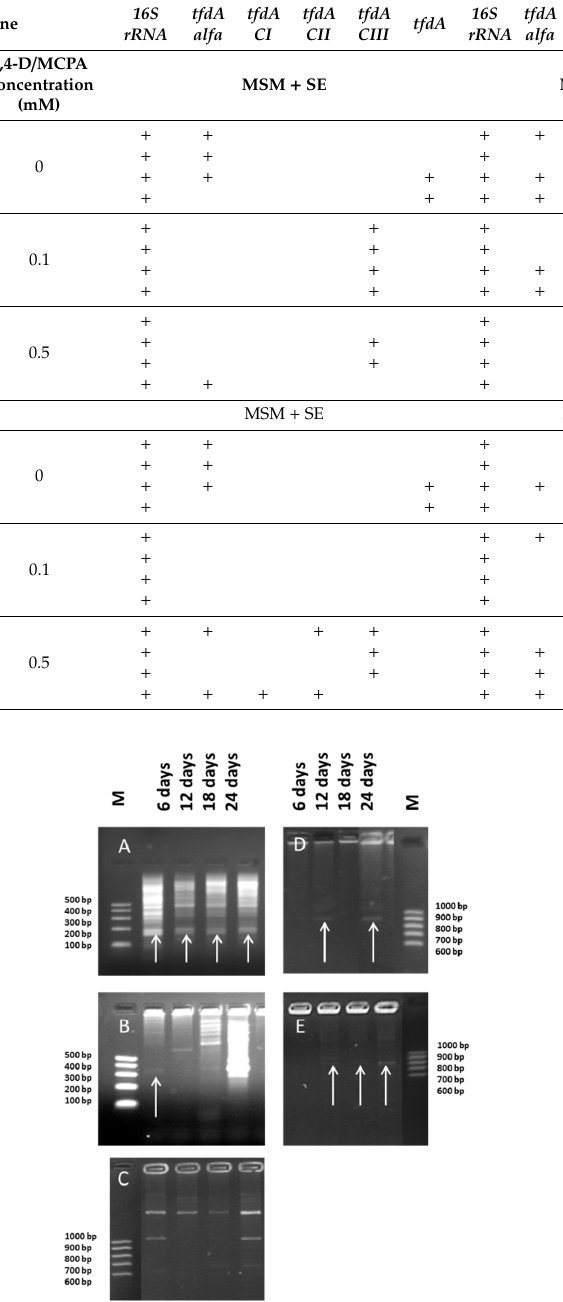
Figure 1. PCR Results Visualized on Gel Electrophoresis for Samples with MCPA (0.1 mM), SE and SA after 6, 12,18, 24 days of incubation; A— 16S rRNA ; B— tfdA α ; C— tfdA Class I; D— tfdA Class II; E—tfdA Class III M—marker, bp—base Table 4. Number of Different Functional Genes Present in Studied Samples After 6, 12, 18, 24 Days of Incubation and Total Number of Detected Functional Genes.